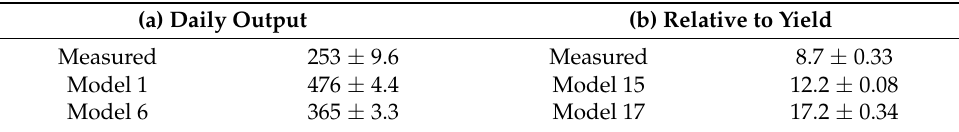
Table 2. Measured methane output compared with model predictions using models from Bougouin et al. [23] for (a) dairy output (g/cow/day) and (b) relative to milk yield (g/kg energy- corrected milk) (means ± SEM).